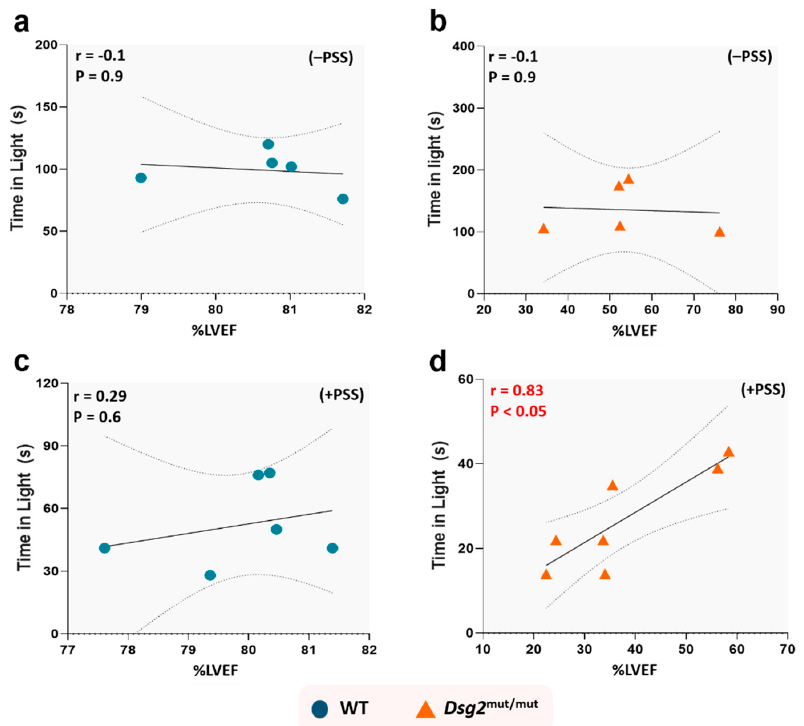
Figure 5. Anxiety levels induced by psychosocial stress correlate with cardiac dysfunction in Dsg2 mut/mut mice. No correlation was found between time spent in light with %LVEF from ( a ) WT mice and ( b ) Dsg2 mut/mut mice not subjected to RI (i.e., − PSS), or ( c ) WT mice after 14 days of RI challenge (i.e., + PSS). ( d ) Conversely, after 14 days of psychosocial stress, Dsg2 mut/mut mice showed a significant correlation between time spent in light and %LVEF ( r = 0.83, p < 0.05). Data displayed in scatterplots; thick black lines represent the best linear fit through data; dotted lines represent two-tailed 95% confidence interval; text inset reports Spearman’s Rho values and associated p ‐ values.